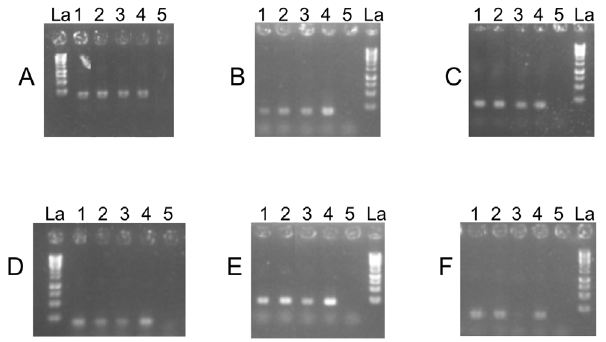
Figure 2. RT-PCR analyses. (A) 16S rRNA, (B) ssol _0230 (4- hydroxyphenyl pyruvate dioxygenase), (C) ssol _1707 (gentisate 1,2 dioxygenase), (D) ssol _2369 (homogentisate 1,2 dioxygenase), (E) ssol _2712 (extra diol ring cleavage dioxygenase), and (F) ssol _2912 (C23D) genes from S. solfataricus . Amplified fragments are 200-bp long. Lane 1: cells of S. solfataricus cultivated with phenol and a DOC of 0.06 mg.L 2 1 . Lane 2: cells of S. solfataricus cultivated with phenol and a DOC of 1.5 mg.L 2 1 . Lane 3: cells of S. solfataricus cultivated in glucose and a DOC of 1.5 mg.L 2 1 . Lane 4: positive control, PCR amplification on genomic DNA as template. Lane 5: negative control experiment performed omitting reverse transcriptase during RT-PCR reaction and showing complete absence of DNA in the RNA samples. La: 1 kb Ladder (Fermentas, France).